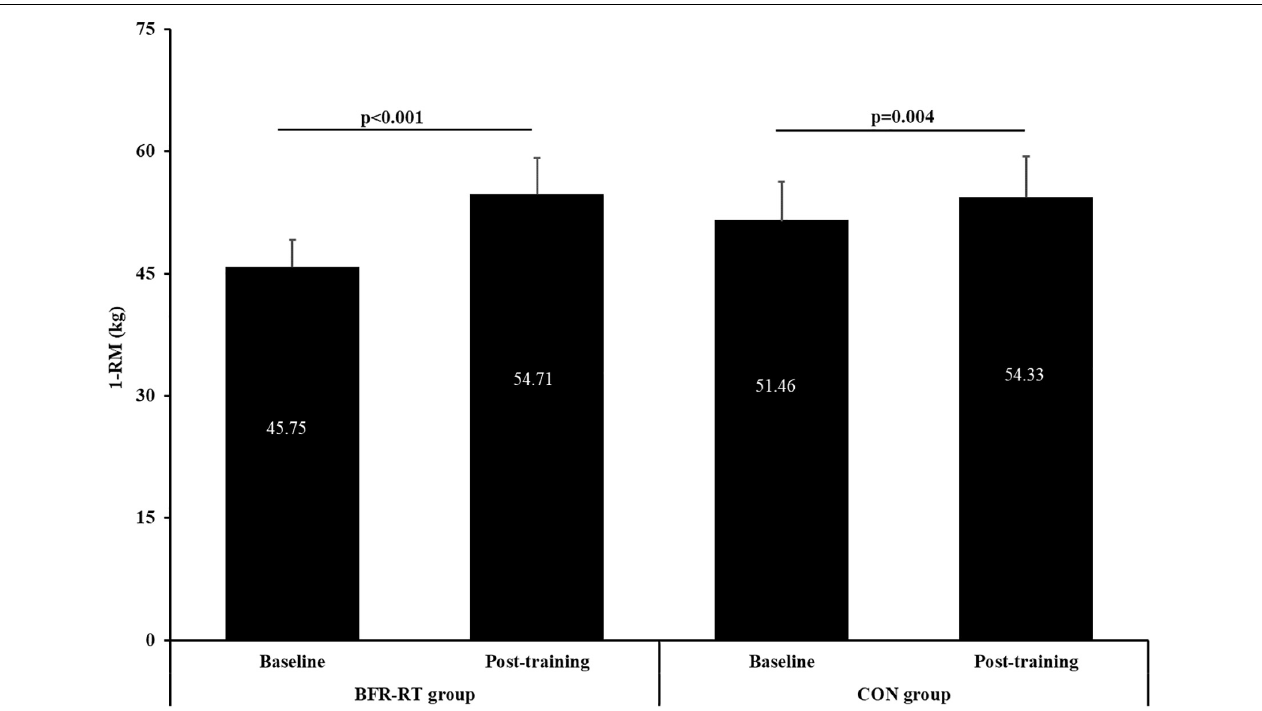
FIGURE 2 | Baseline and post-training values of one repetition maximum (1-RM) for both groups. BFR-RT group, blood flow restriction-resistance training group; CON group, control group. Values are presented as mean ± SE.